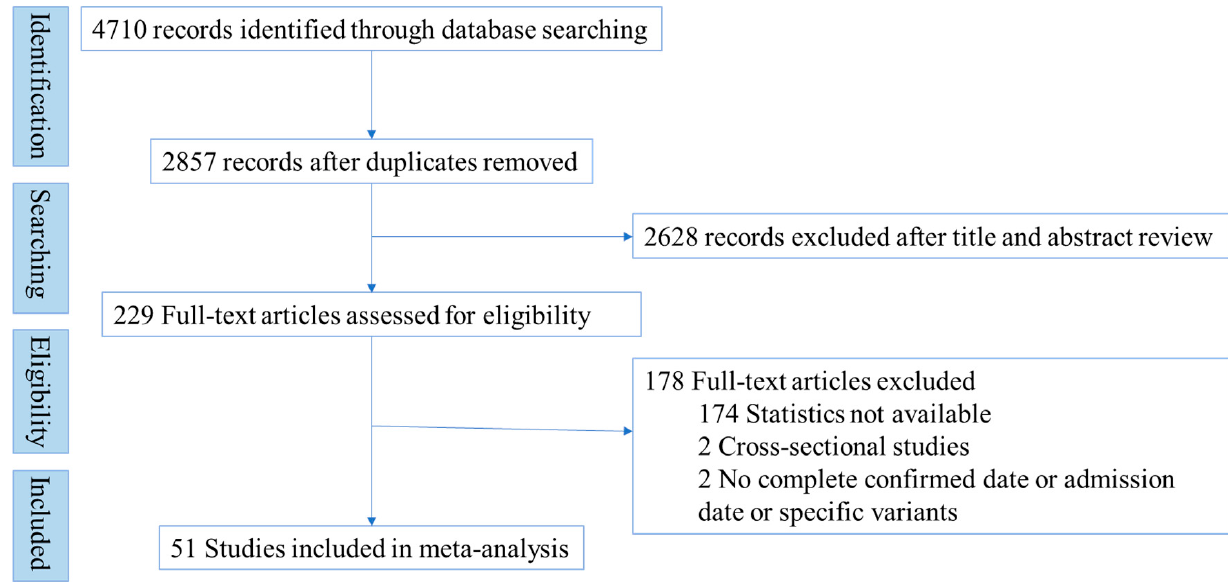
Figure 1. Study flow diagram.